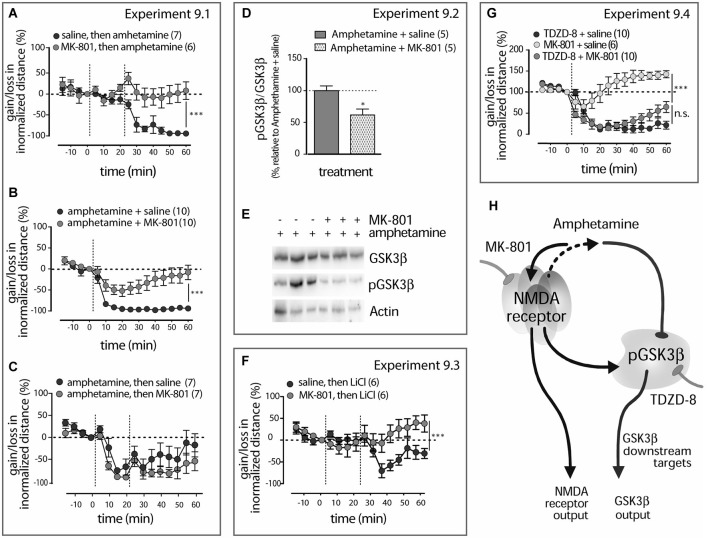
Amphetamine action in LAB mice interfere with NMDA receptor signaling (A). Pre-treatment (−20 min) with MK-801 abolishes amphetamine effect on the locomotor activity in LAB mice. The dashed lines mark the moments either of saline and amphetamine (1 mg/kg, i.p.) or MK-801 (0.3 mg/kg, i.p.) and amphetamine (1 mg/kg, i.p.) administration. **p < 0.01. (B). Co-treatment with MK-801 counteracts the amphetamine calming effect in LAB mice. The dashed lines mark the moments of either saline + amphetamine (1 mg/kg, i.p.) or MK-801 (0.3 mg/kg, i.p.) + amphetamine (1 mg/kg, i.p.) administration. ***p < 0.001. (C). MK-801 post-treatment (+20 min) did not interfere with amphetamine action. The dashed lines mark the moments of amphetamine (1 mg/kg, i.p.) and MK-801 (0.3 mg/kg, i.p.) injections. (D). Decrease in the phospho-Ser9-GSK3β levels in the mPFC of LAB (n = 5/5) mice 60 min after MK-801 (0.3 mg/kg, i.p) and amphetamine (1 mg/kg, i.p.) co-treatment and coinciding with OF exposure. *p < 0.05 vs. amphetamine + saline. (E). Representative Western blots for the analysis of GSK3β, pGSK3β protein levels in LAB mice. Bands include samples both from amphetamine + saline- and amphetamine + MK-801-treated animals. (F). MK-801 pre-treatment (−20 min) effectively collapses the calming effect of LiCl. The dashed lines mark the moments of MK-801 (0.3 mg/kg, i.p.) and LiCl (100 mg/kg, i.p.) injections. ***p < 0.0001. (G). MK-801 does not interfere with the activity of the pure GSK3β inhibitor TDZD-8 in its ability to modulate locomotor activity in LAB mice. The dashed lines mark the moments of either MK-801 (0.3 mg/kg), saline + TDZD-8 (20 mg/kg, i.p.) or MK-801 (0.3 mg/kg, i.p.) + TDZD-8 (20 mg/kg, i.p.) administration. Since there was no difference between saline and 0.5% DMSO treatment, results for both vehicle-treated groups were pooled together. ***p < 0.001, n.s. non significant. (H). Hypothetical scenario: amphetamine effects on GSK3β comprise NMDA receptor-mediated kinase slowdown (due to glutamate release) rather than any direct effect. This pathway, unidentified in details, is uniquely activated in the mPFC of LAB mice and leads to GSK3β inhibition. Hypofunction of NMDA receptors might be a permissive cause of this pathway activation.